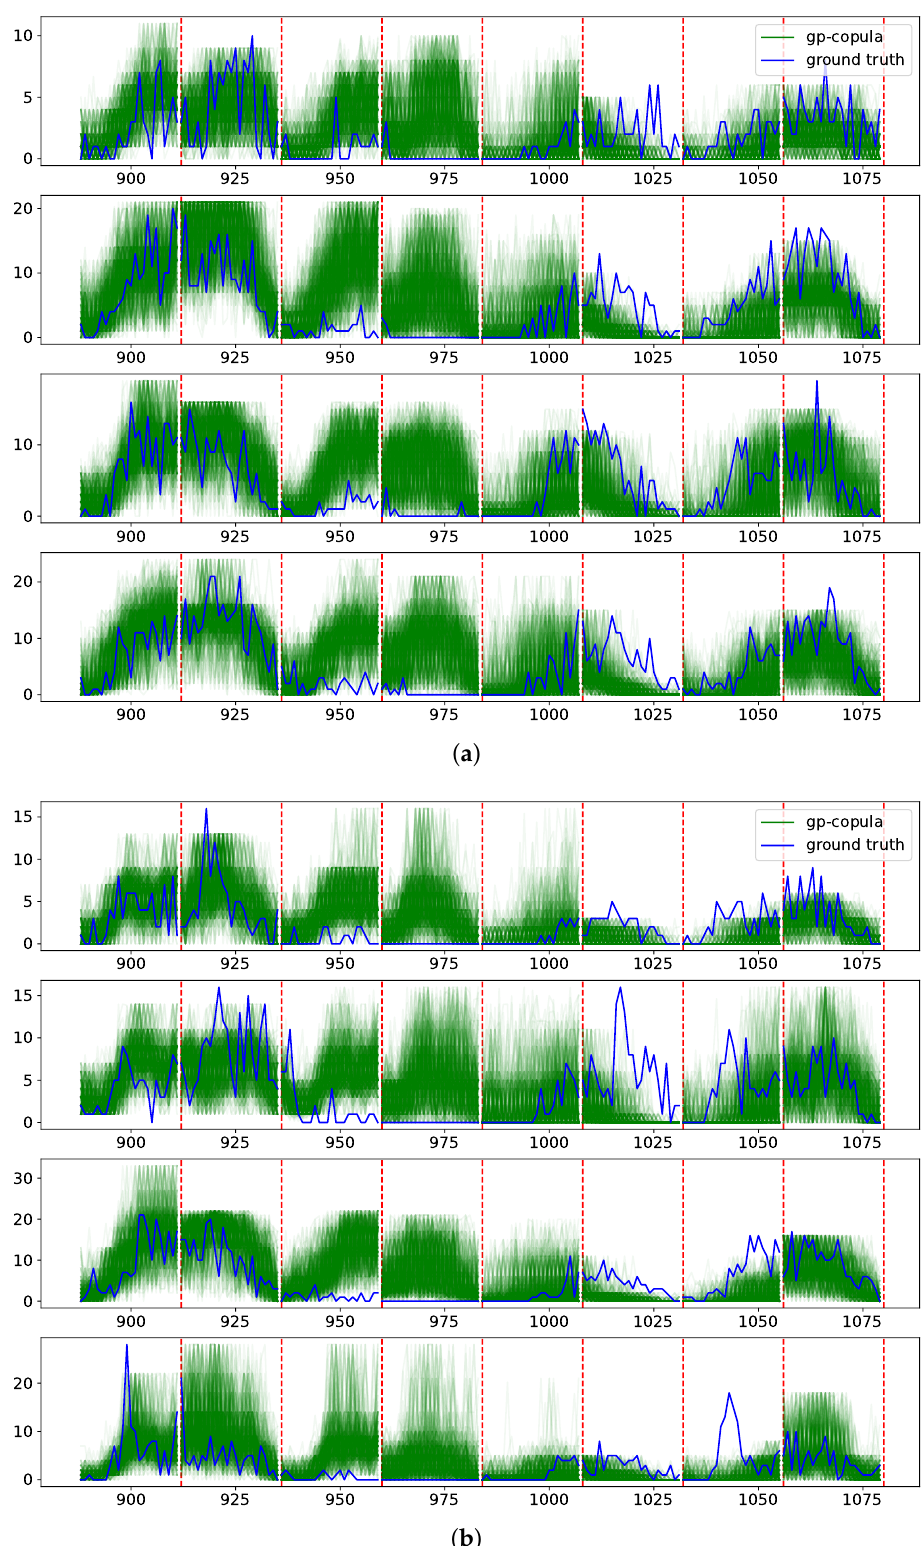
Figure 4. These figures illustrate the 400 forecast samples from the GP-copula model on the taxi dataset. ( a ) Visualization of the GP-copula model on four dimensions of the taxi dataset with the best performance based on CRPS. ( b ) Visualization of the GP-copula model on four dimensions of the taxi dataset with the worst performance based on